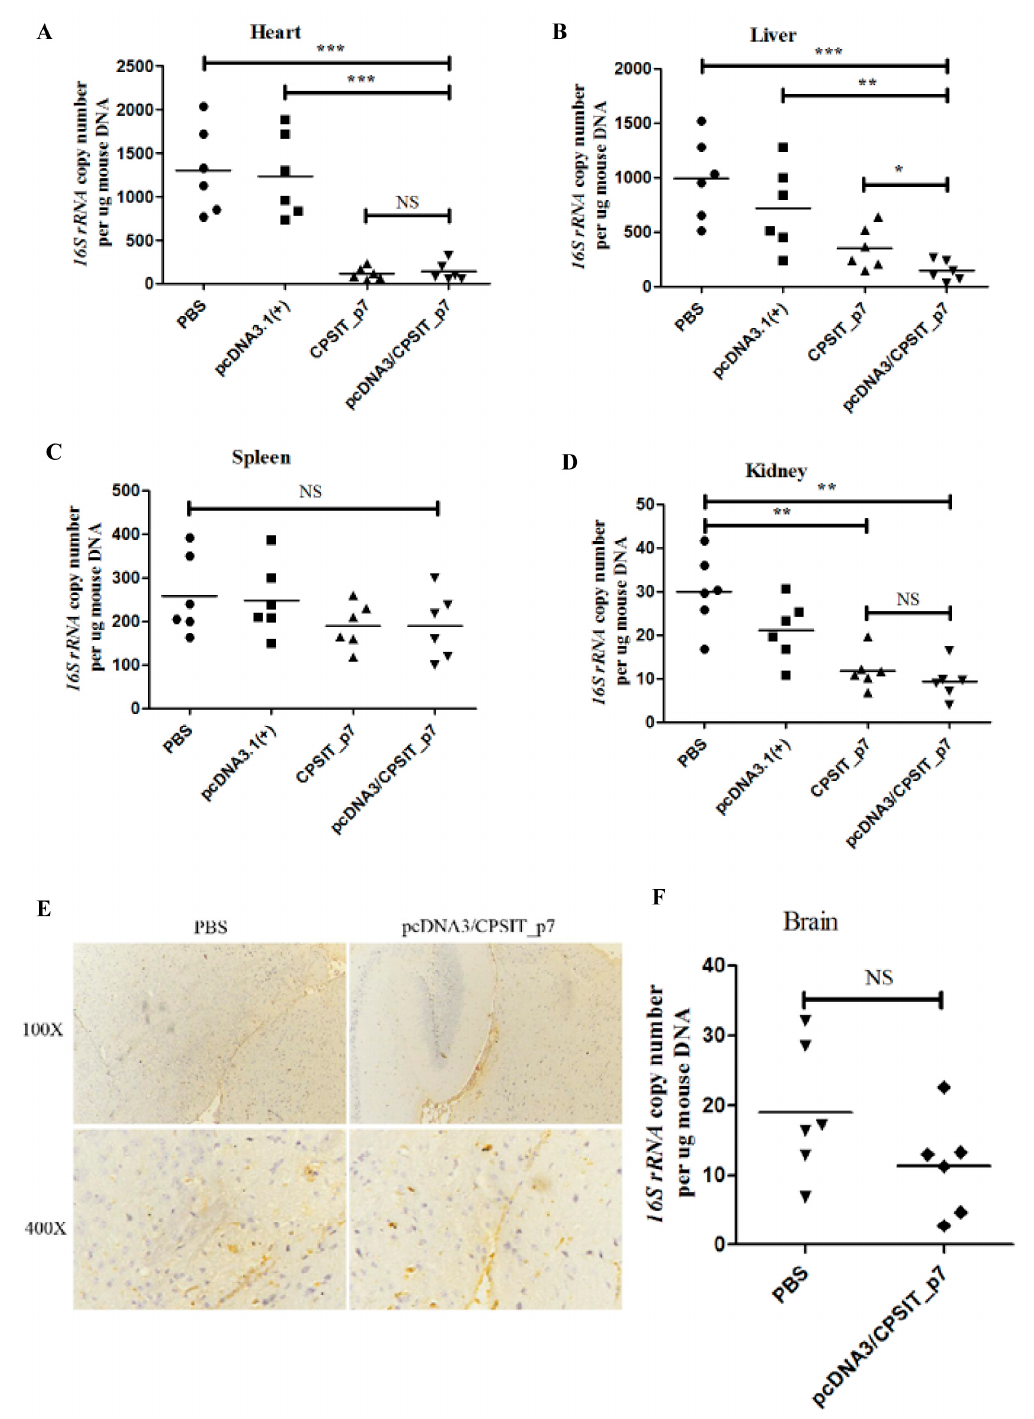
Figure 6. Detection of C. psittaci load in various organs of infected mice. Quantitative real-time PCR was used to measure the 16s rRNA DNA concentrations in the ( A ) heart, ( B ) liver, ( C ) spleen, ( D ) kidney, and ( F ) brain of mice in each group. The results were normalized to the mice’s DNA concentrations using the Mann–Whitney test. The points correspond to three samples that were separately extracted from each mouse. Horizontal lines represent mean values (* p < 0.05, ** p < 0.01, *** p < 0.001, NS = no significance). ( E ) Illustrative immunohistochemical photographs of the brain from different groups of infected mice after immunization.